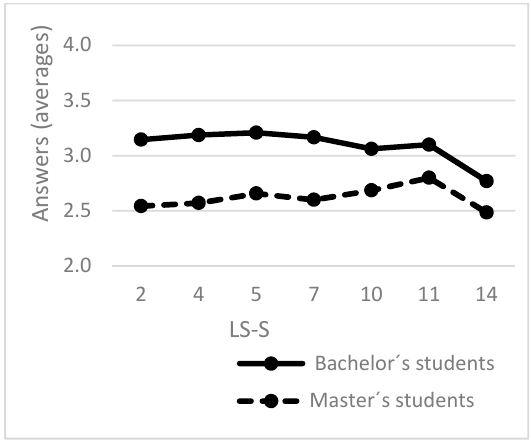
Figure 4. Answers of undergraduate and graduate students in LS-S.